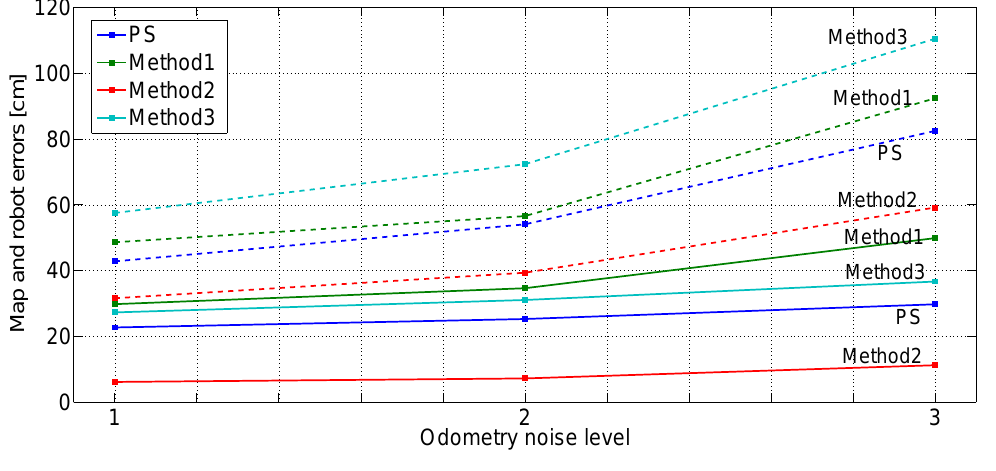
Figure 15. Robustness of Method1 , Method2 and Method3 and the proposed scheme (PS) against odometry noise level: the mean robot errors are in full lines, while the mean map errors are in dashed